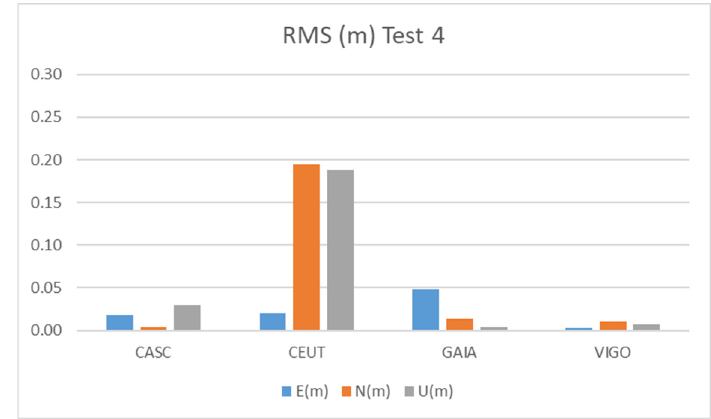
Figure 16. RMS results for Galileo + GPS combination at Test 4.